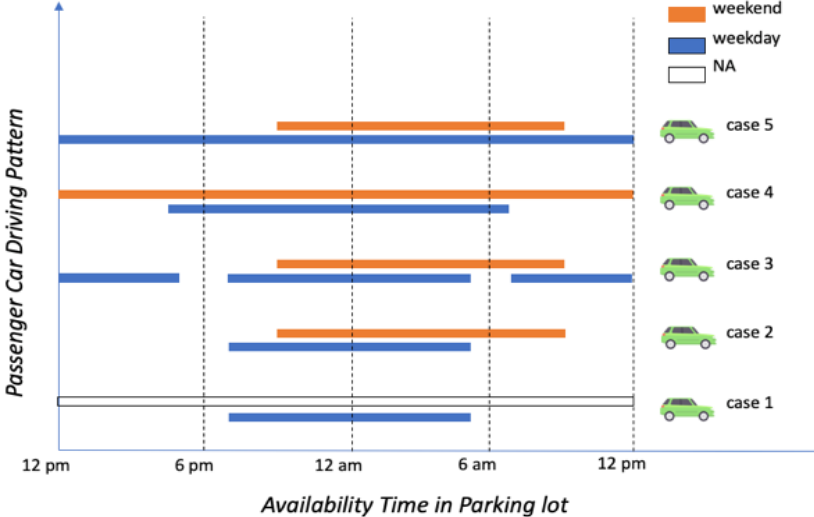
Figure 5. Driving pattern of EVs based on private vehicle usage and availability for V2G connection.